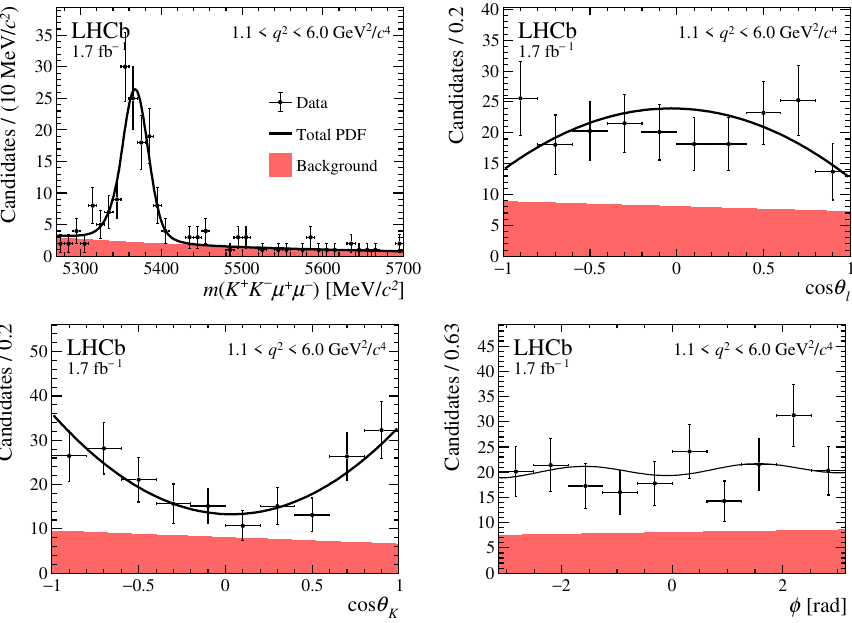
Figure 28 . Mass and angular distributions of B 0 1 . 1 < q 2 < 6 . 0 GeV 2 /c 4 for data taken in 2016. The data are overlaid with the projections of the fitted PDF.